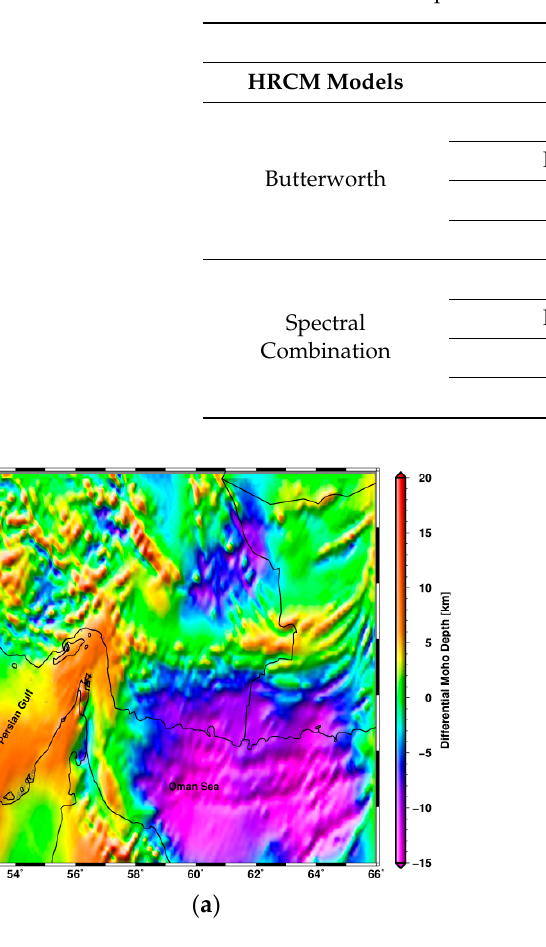
Figure 8. The Moho depth differences between ( a ) the HRCM Butterworth filter solution and the Makran Moho model [31] and ( b ) the HRCM spectral combination solution and the Makran Moho model [31]. Unit: km.